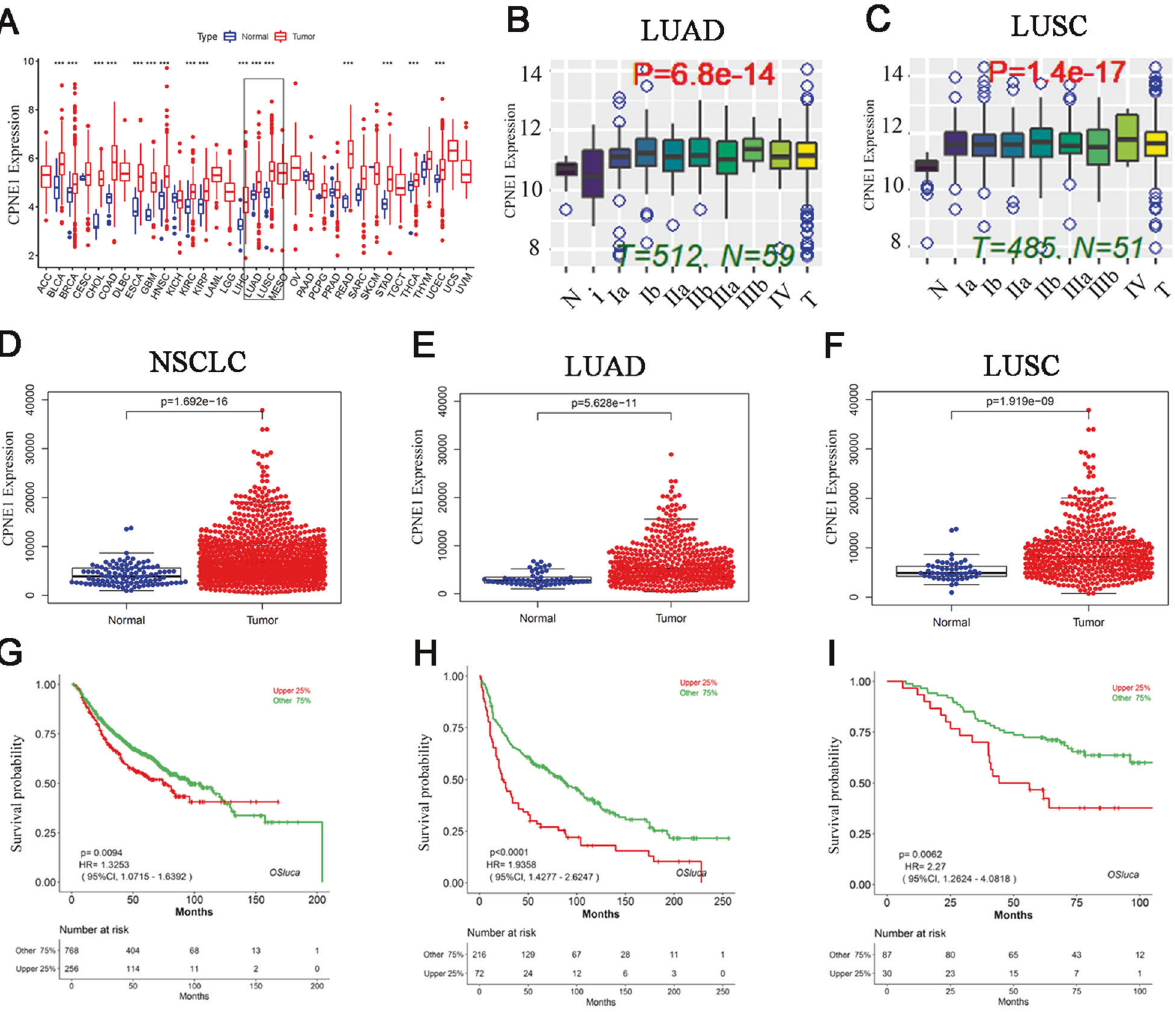
Fig. 1 CPNE1 is elevated in lung cancer and correlates with poor survival. A CPNE1 is upregulated in a variety of cancers. B , C CPNE1 expression is correlated with the TNM stage of patients with lung adenocarcinoma/lung squamous cell carcinoma. P < 0.05 indicates that a difference of CPNE1 between groups (tumor and normal) was signi fi cant. D – F CPNE1 is overexpressed in NSCLC. G – I CPNE1 expression is correlated with poor survival in lung adenocarcinoma/lung squamous cell carcinoma. All statistical analysis applied in the results are Student ’ s t test. Cell Death Discovery (2021)